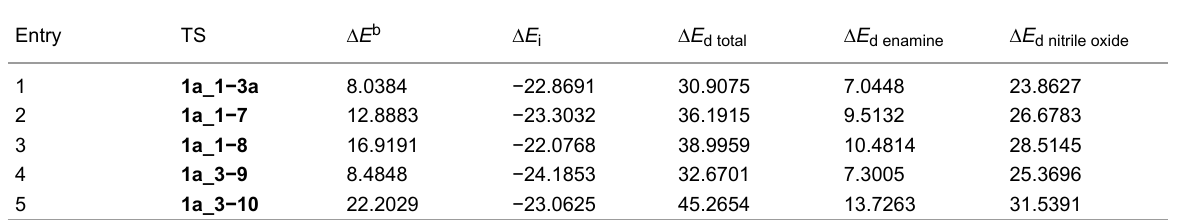
Table 1: Calculated data of the electronic activation energy ( ∆ E ), orbital interaction energy ( ∆ E i ), and geometry distortion energies ( ∆ E d ). a